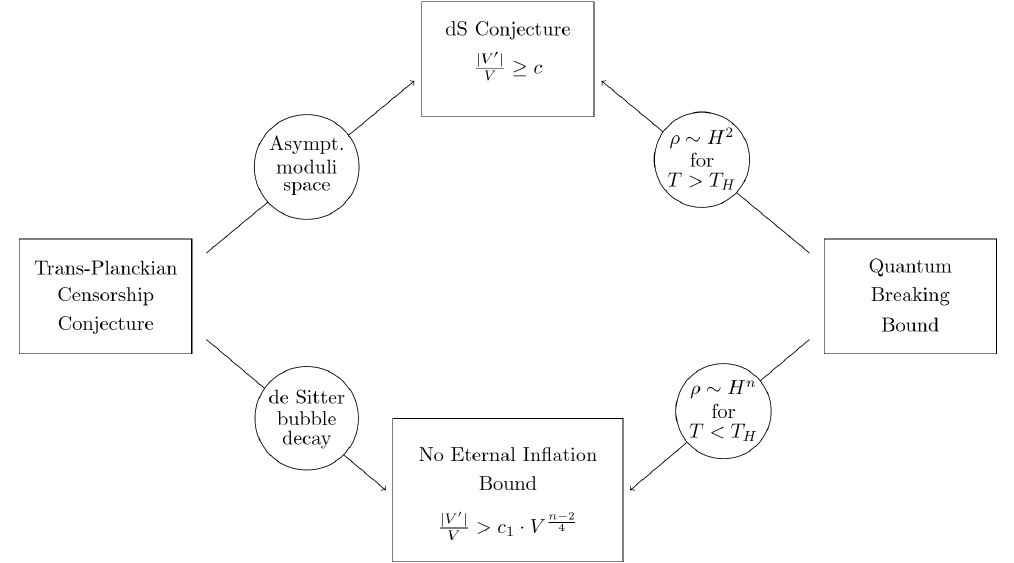
Figure 9 . Schematic depiction of bounds for n-dimensional V and their